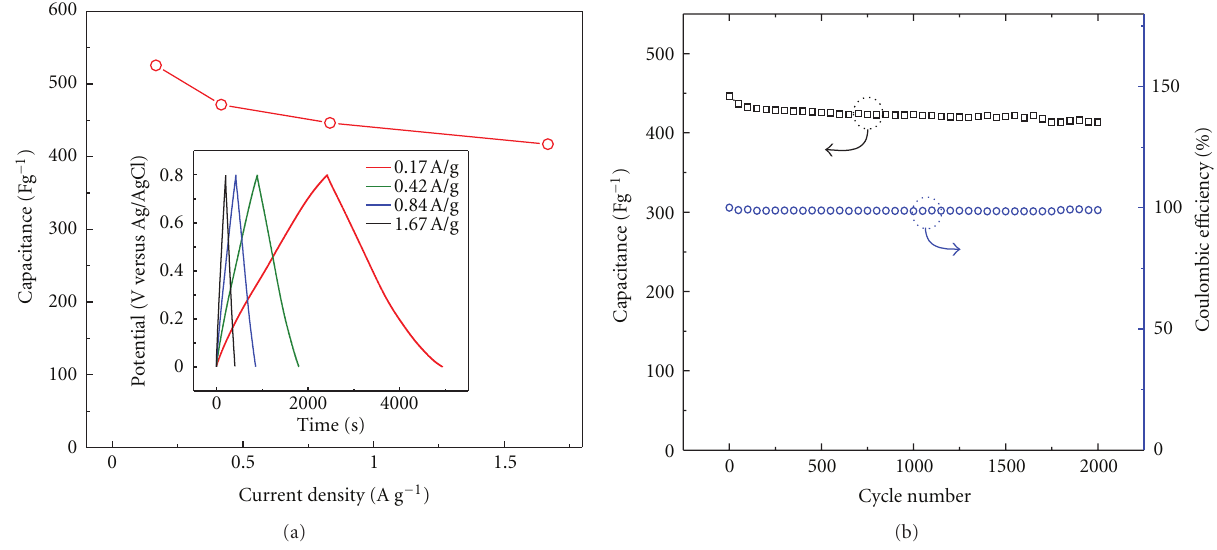
Figure 8: (a) Variation in gravimetric capacitance of MnO 2 /CNxNTs/CC hybrid electrode (deposition time of 150 min) with di ff erent current density and the inset is the corresponding charge-discharge curves. (b) Cycle life of MnO 2 /CNxNTs/CC